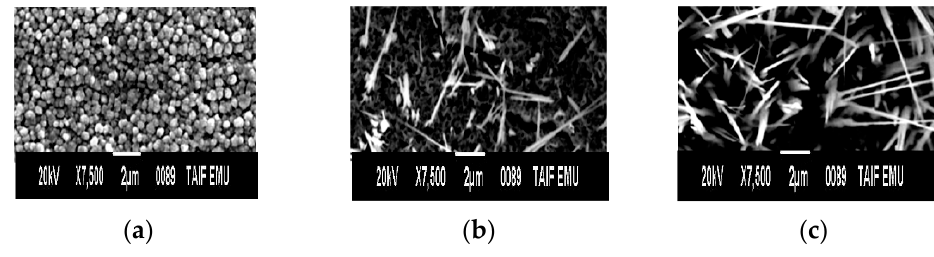
Figure 8. CuO SEM images at ( a ) room temperature, ( b ) 300 °C, and ( c ) 500 °C.